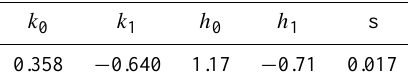
Table 1. Values used in Eq. (6) to calculate the light absorption coefficients with the iterative method described by Virkkula et al. (2005). The coefficients are from Virkkula